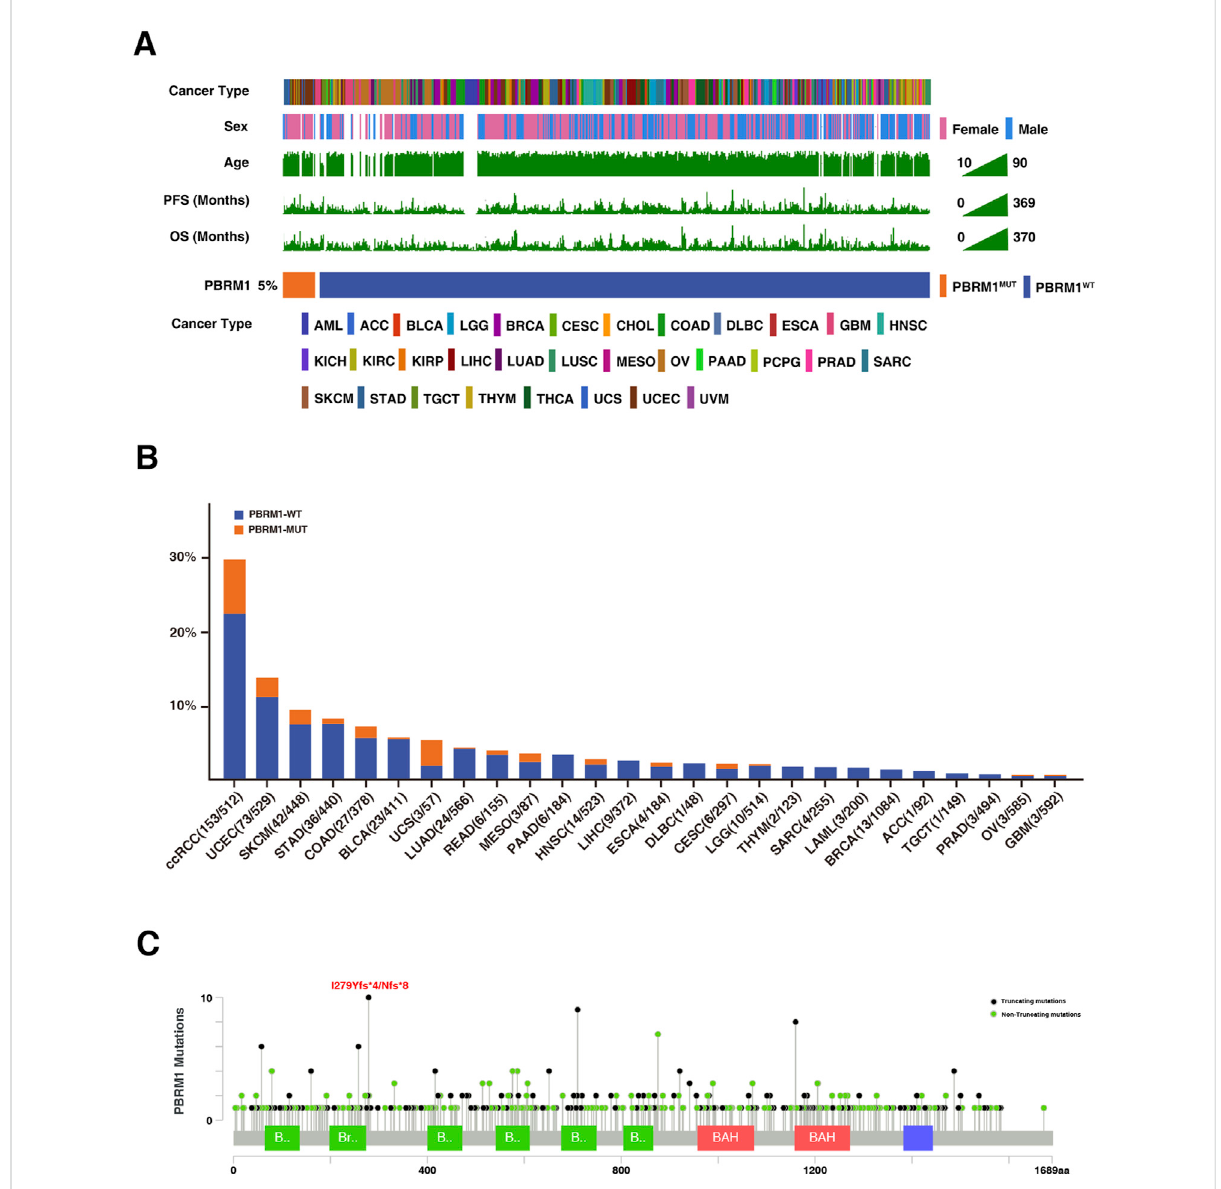
FIGURE 5 Mutational landscape of PBRM1 in TCGA cohort. (A) Association of PBRM1 status and clinical characteristics in TCGA cohort. The cancer type, sex, age, TMB, PFS, and OS were annotated. Samples were sorted by PBRM1 status, while PBRM1-MUT and PBRM1-WT samples were separated by